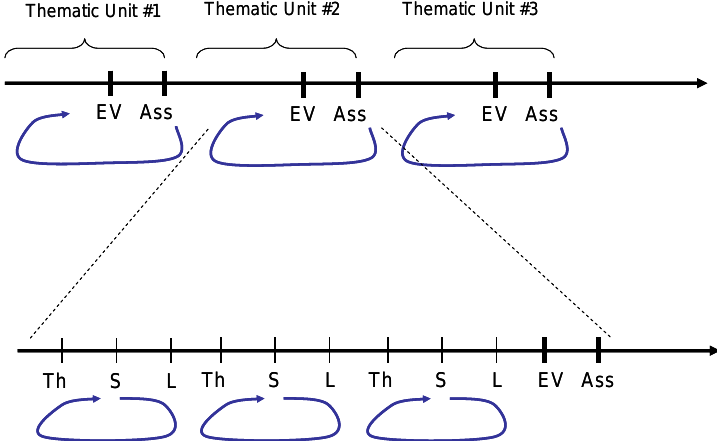
Fig. 4: Timeline perspective of subject activities organization. For each thematic unit there is a sequence of feedback loops defined according to the teaching activities.